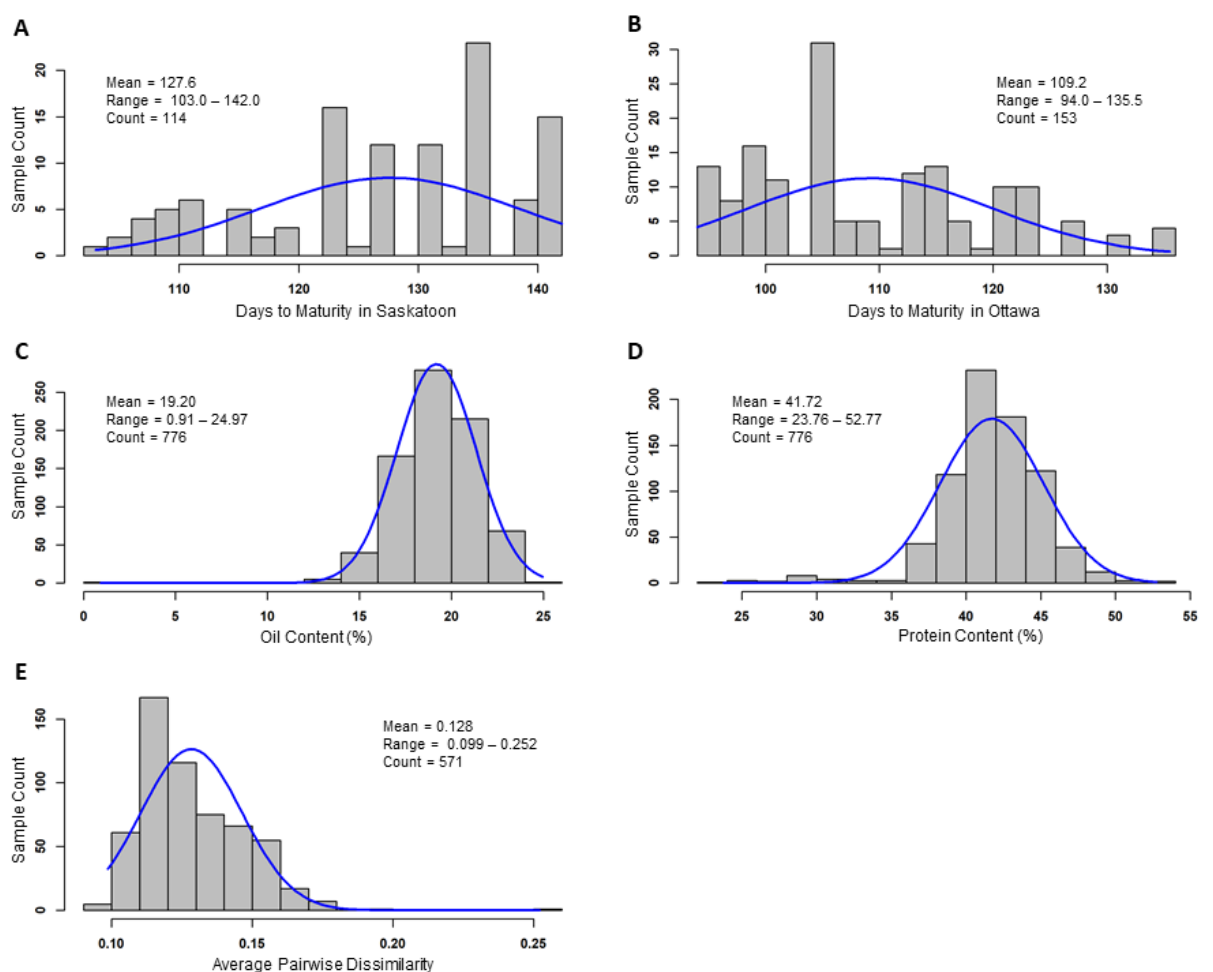
Figure 1. The distribution of observed values for the assayed soybean accessions in maturity, oil and protein concentration, and genetic distinctness. Panels ( A , B ) show the variabilities of soybean maturity observed in Saskatoon and Ottawa in 2018, respectively. Panels ( C , D ) illustrate the distributions of oil and protein concentration, respectively. Panel ( E ) displays the variability of genetic distinctness measured with average pairwise dissimilarity.